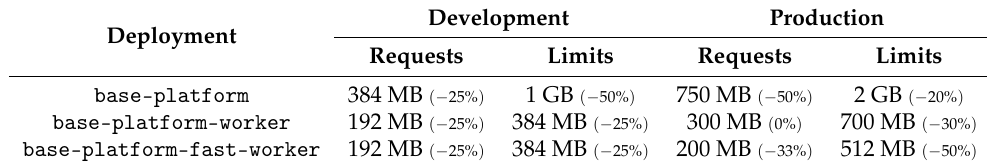
Table 3. Recommended resource allocation per microservice deployment.